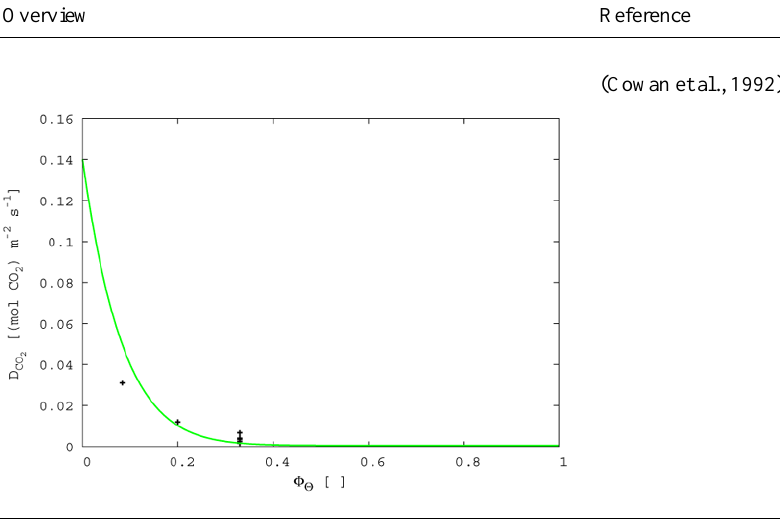
Fig. B10. Diffusivity for CO 2 , D CO , as a function of water saturation 8 2 . The black data points are derived from the study listed in the 2 right